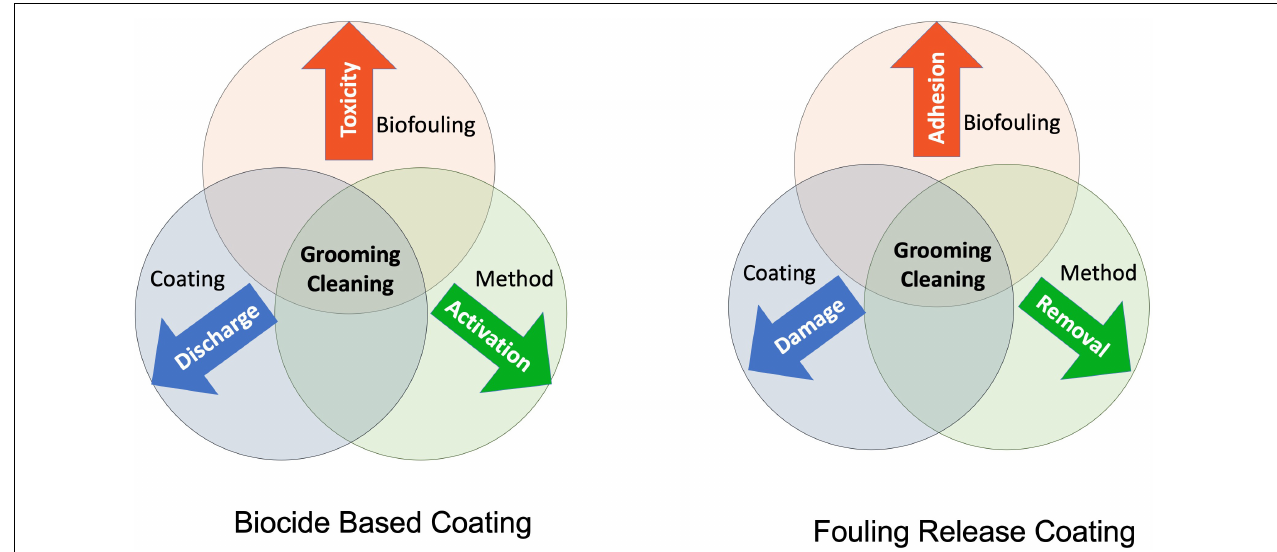
FIGURE 3 | Grooming method requirements for biocide based and fouling release